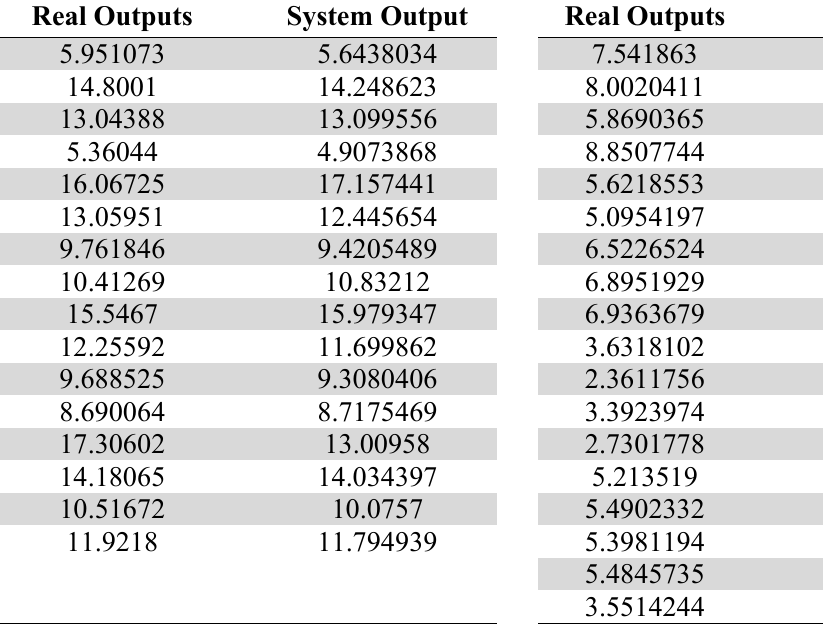
Comparing the Outputs of Insurance or Un- derwriting Risk Evaluation Model with Real Outputs Real Outputs System Output Real Outputs System